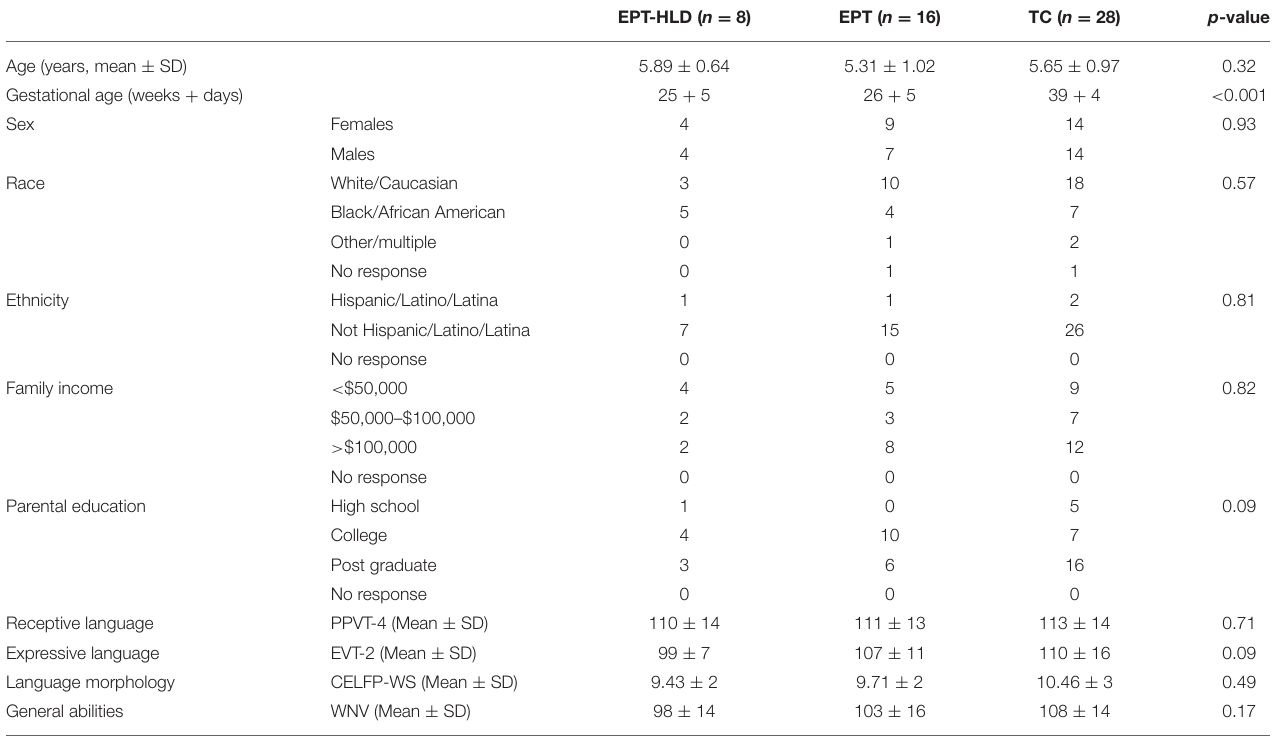
TABLE 2 | Demographics and neuropsychological data for entire